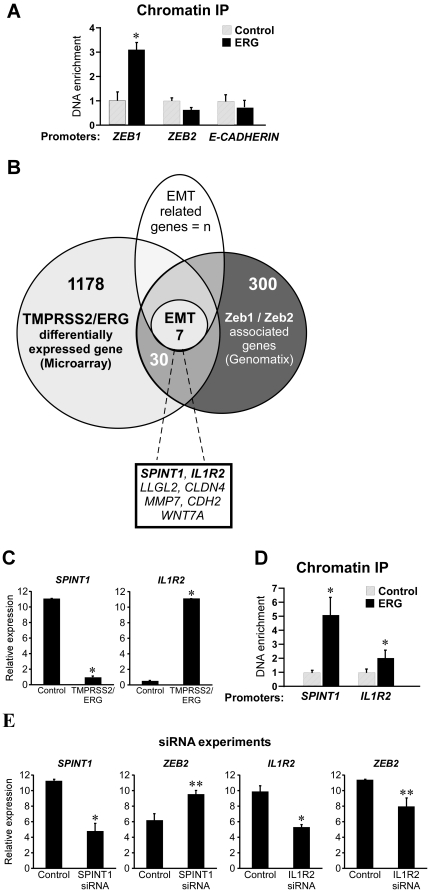

TMPRSS2/ERG induces an EMT transcription program.(A) Chromatin-IP assay was performed in EP-AR TMPRSS2/ERG cells using α-ERG antibody and IgG as a control. The results are presented as mean ±SD of a triplicate from a representative experiment. * denotes P-value<3×10−2. (B) The list of 1215 differentially expressed genes was intersected with a list of genes associated with ZEB1 or ZEB2, which was obtained from the “Genomatix” software [47], resulting in 37 shared genes. The 37-genes list was filtered for genes associated with EMT according to the literature (n  =  unknown sample size), leaving the 7 genes that are listed in the box below. (C) Cells were analyzed for SPINT1 and IL1R2 expression using QRT-PCR. The results are presented as mean ±SD of a triplicate from a representative experiment. * denotes P-value<5×10−4. (D) Same set-up as (A) was used for IL1R2 and SPINT1 promoters (E) Left panels: EP-AR cells were transfected with siRNA targeting SPINT1 and mRNA expression of the designated genes was measured by QRT-PCR. The results are presented as mean ±SD from two experiments utilizing two different siRNA oligonucleotides. * denotes P-value = 7×10−4, ** denotes P-value = 1×10−3. Right panels: the same experimental set-up was used with siRNA targeting IL1R2 in EP-AR TMPRSS2/ERG. * denotes P-value = 2×10−4, ** denotes P-value = 1×10−2.